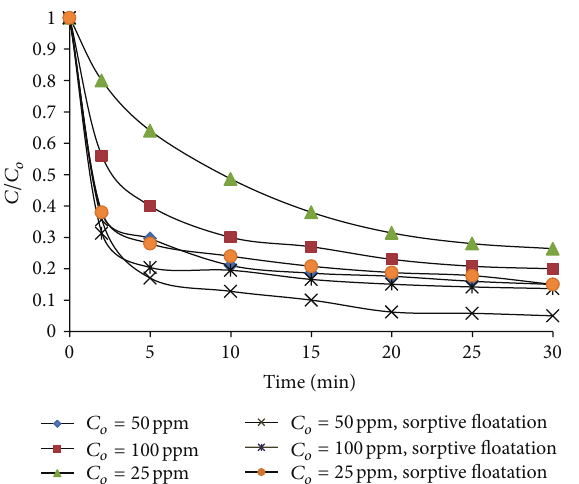
Figure 6: Effect of lead concentration on the removal efficiency at SDS = 25mg/L; pH = 8; 𝑄 = 1000 mL/min; barley husk = 20gm/L). Table 2: Pseudo-first and second-order rate constants for Pb(II) with correlation coefficients ( 𝑅 2 ). Pseudo-first-order kinetic Pseudo-second-order model kinetic